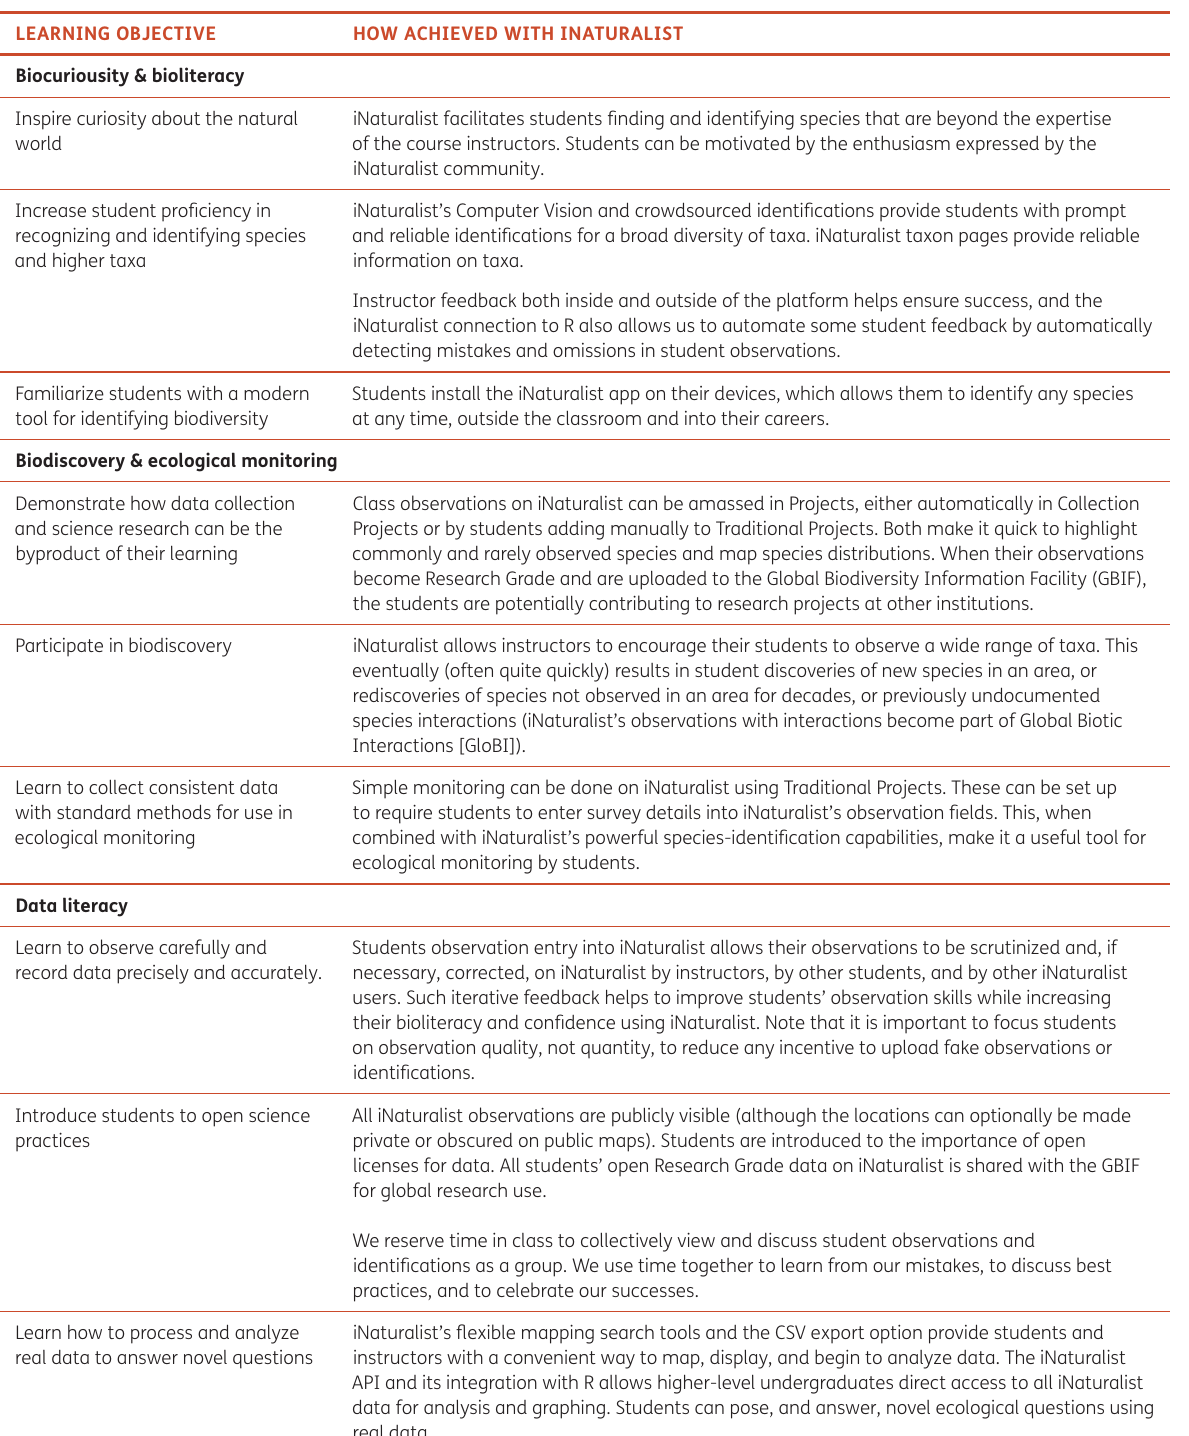
Table 1 How undergraduate learning objectives around biocuriousity and bioliteracy, biodiscovery and ecological monitoring, and data literacy, can all be met by incorporating iNaturalist into undergraduate courses. The three case studies detailed in the text differ in their emphasis on each